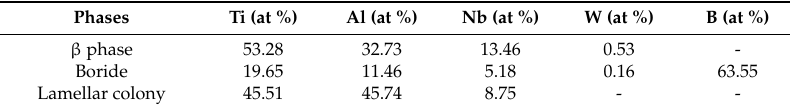
Table 4. EDS (energy-dispersive X-ray spectroscopy) analysis in Figure